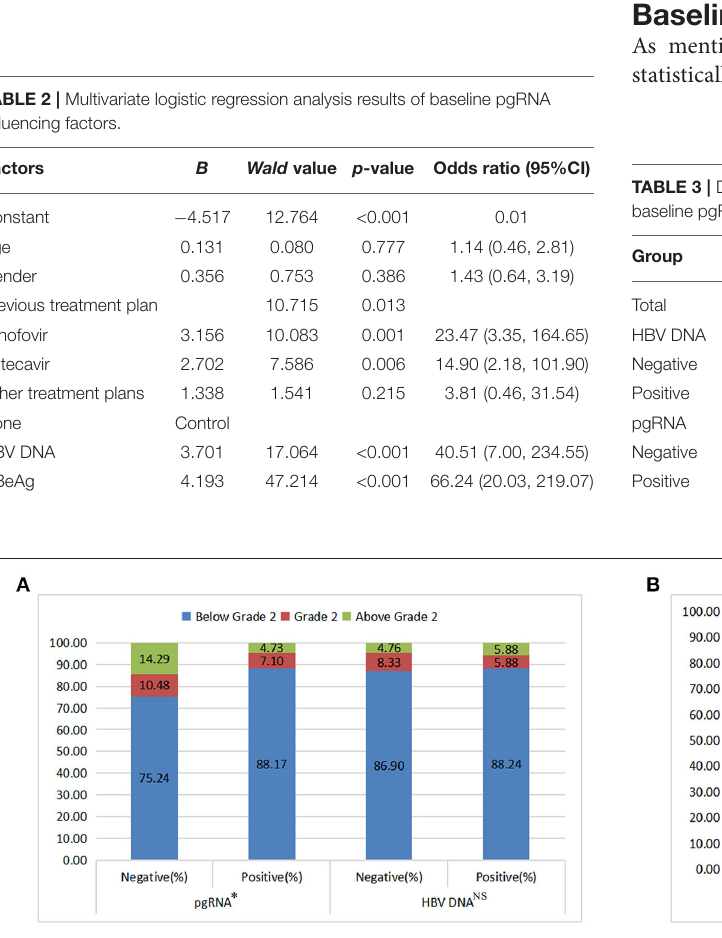
FIGURE 1 | The results of chi-square tests ( A : FIB-4 grade among different baseline pgRNA and HBV DNA groups; B : incidence of a significant decrease in HBsAg between different baseline pgRNA groups).